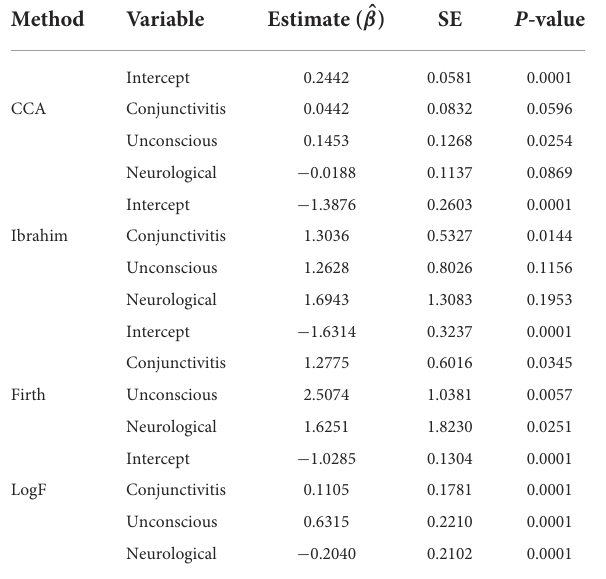
TABLE 2 Performance of LogF against the Ibrahim and Firth methods.